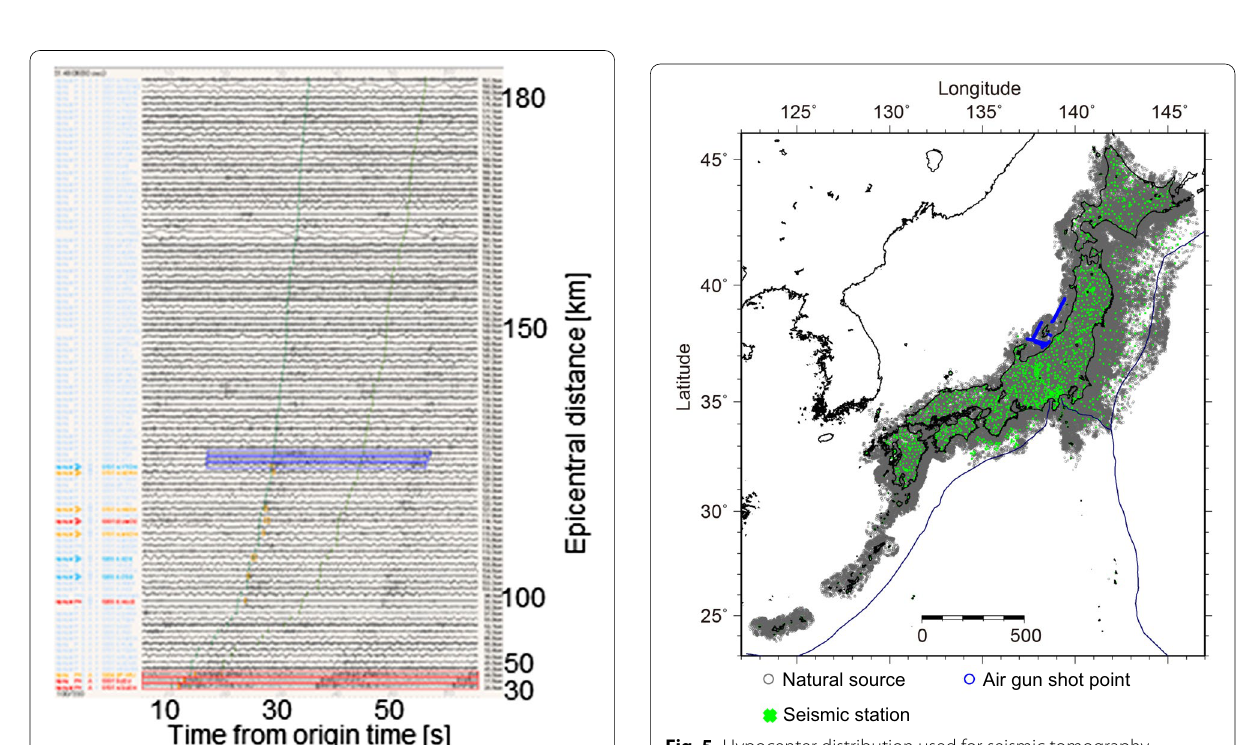
Fig. 4 Example stacked waveform of air gun shots to 180 km